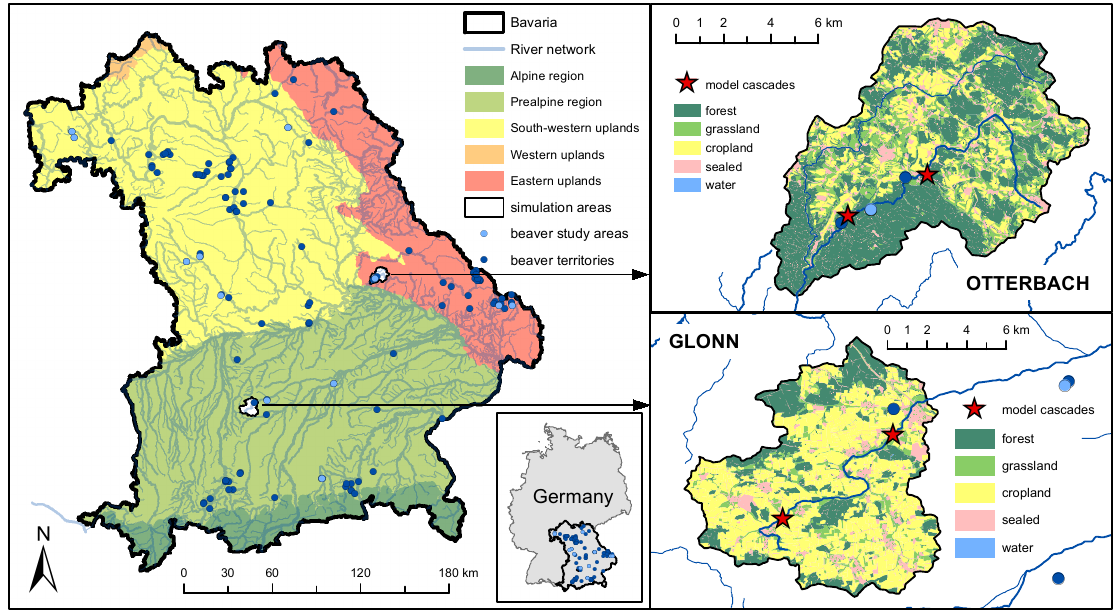
Figure 1. Locations of the investigated beaver territories and the simulation areas in